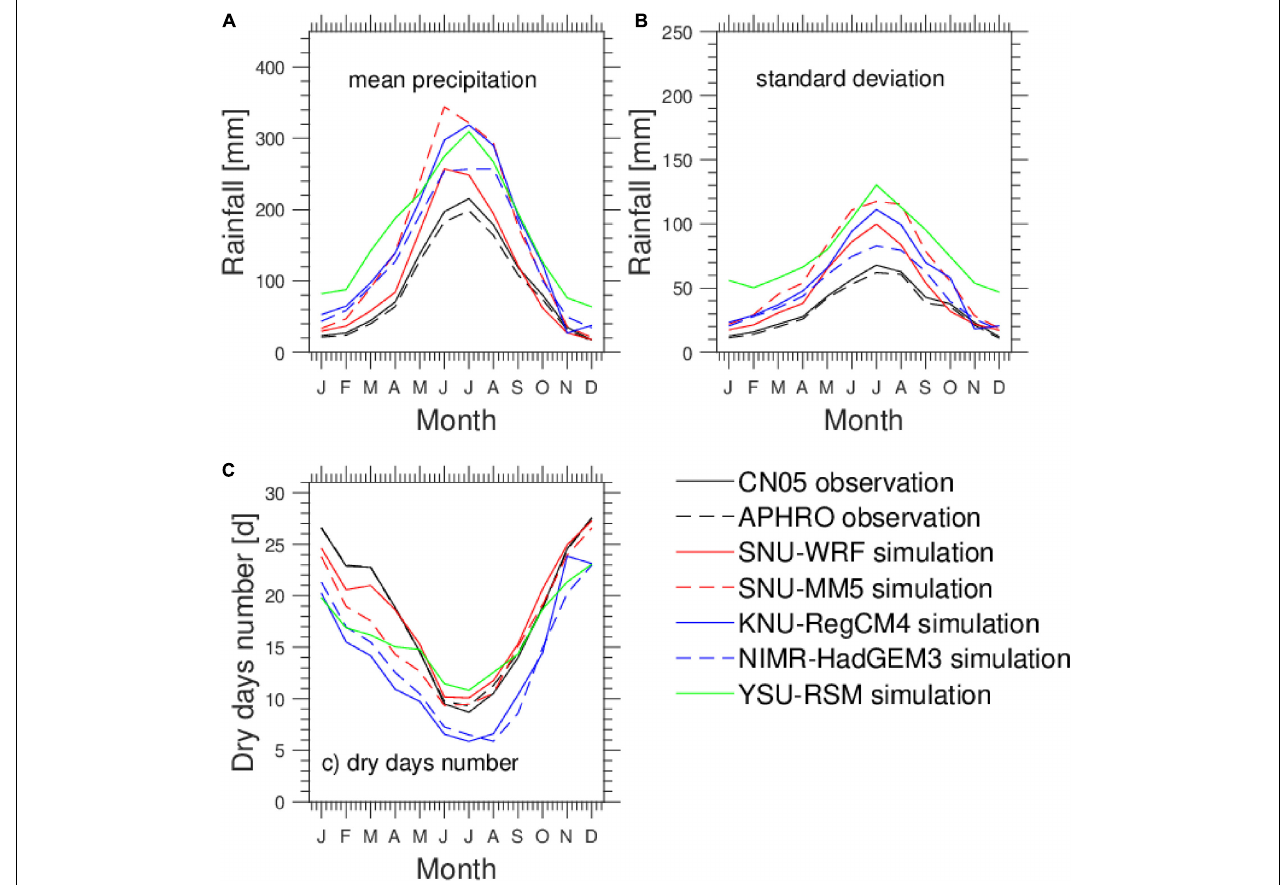
FIGURE 2 | (A) Annual cycle of area-averaged monthly mean precipitation over SWC. (B) Annual cycle of area-averaged monthly standard deviation of monthly mean precipitation. (C) Annual cycle of area-averaged monthly mean number of dry days. The different line types represent two observations (CN05 and APHRO) and five RCM simulations (SNU-WRF, SNU-MM5, YSU-RSM, KNU-RegCM4, and NIMR-HadGEM3), respectively.